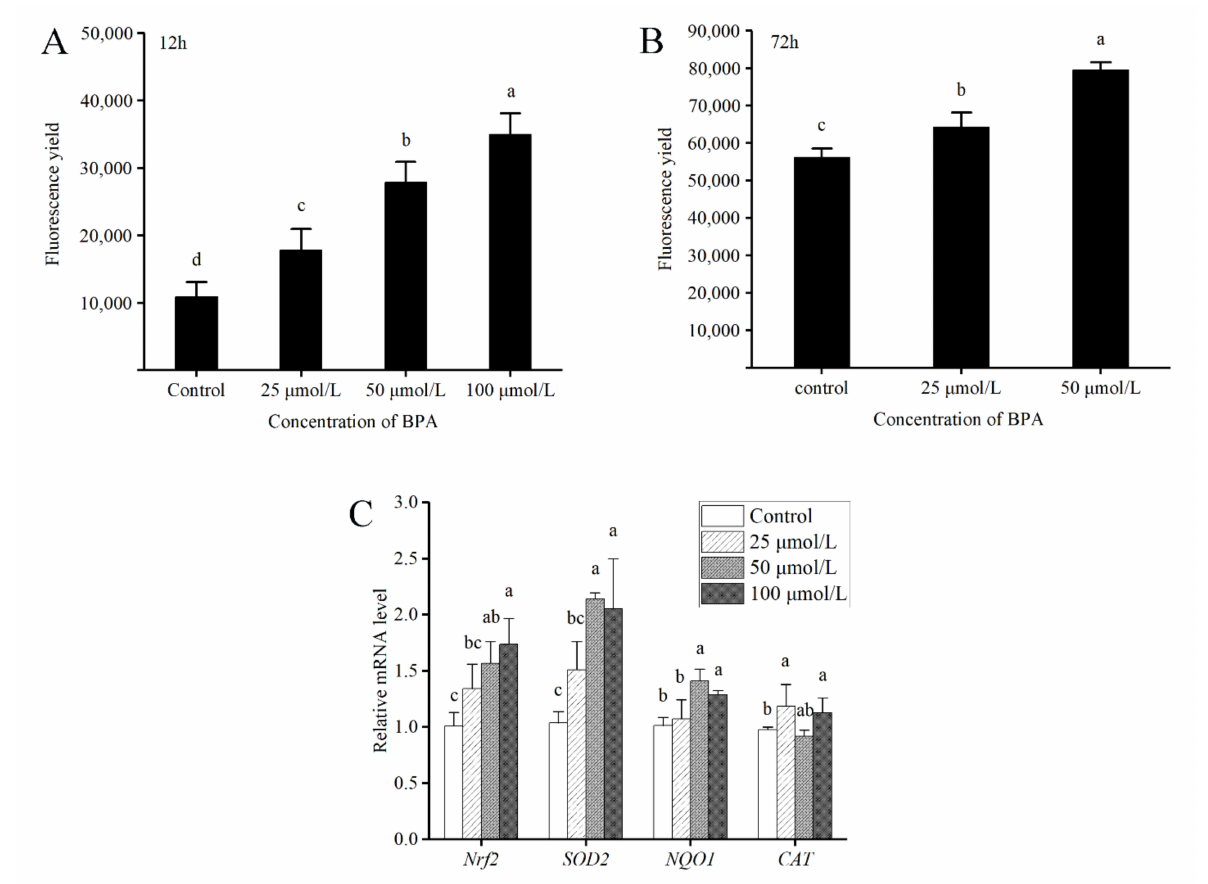
Figure 3. BPA exposure enhances redox signaling during embryonic development. The ROS levels were measured at the time of BPA removal (after exposure for 12 h) ( A ) and at the statistical analysis endpoint (72 h) ( B ). n = 3/treatment. ( C ) The representative genes involved in the redox signaling pathway were determined at the time of BPA removal (12 h). Different letters above the bars indicate significant differences among groups (a > b > c > d, p < 0.05). n = 3/treatment.